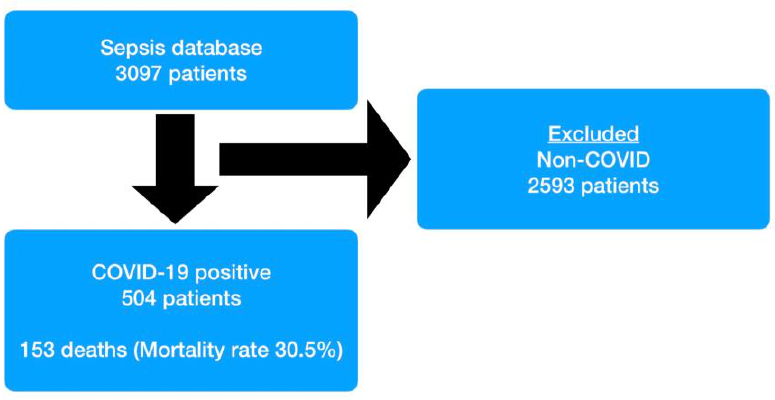
Figure 1. Patient flow diagram.